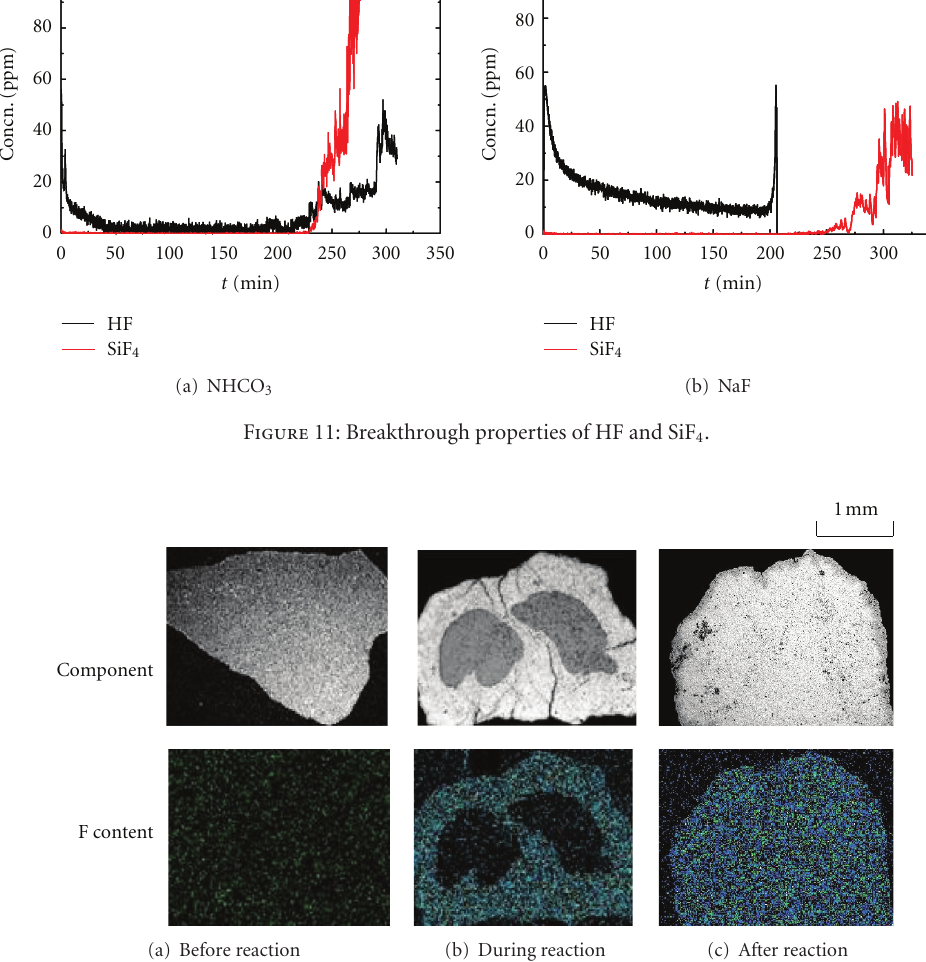
Figure 12: EPMA photographs of the CaCO 3 adsorbents before and after experiments.